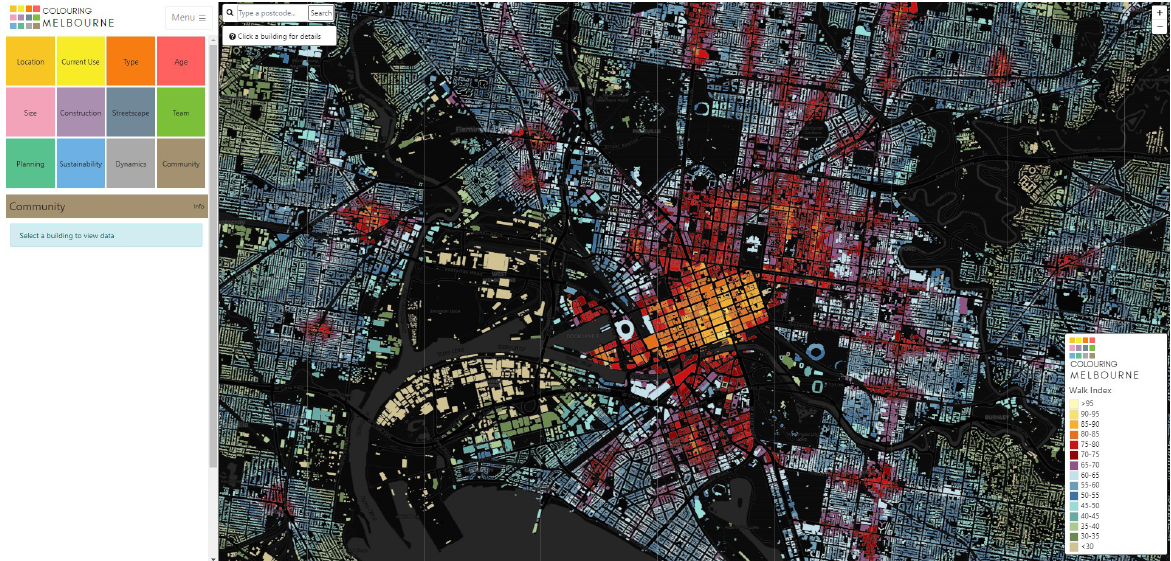
Figure 2. Building footprints in the CBD and inner suburbs of Melbourne with walkability